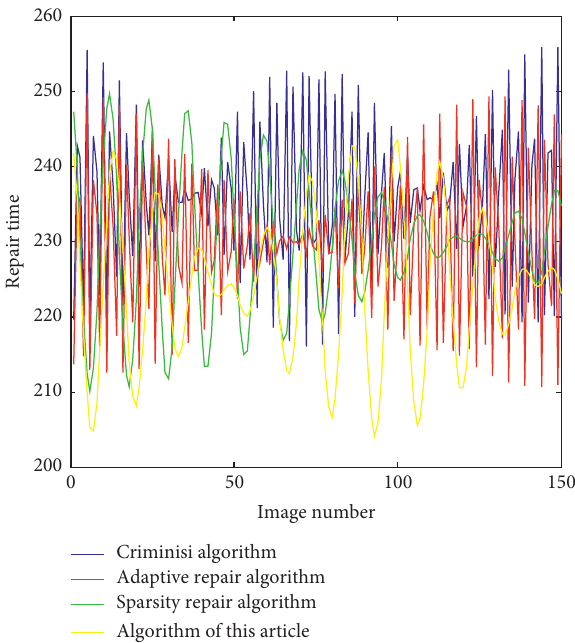
Figure 15: Repair time of each